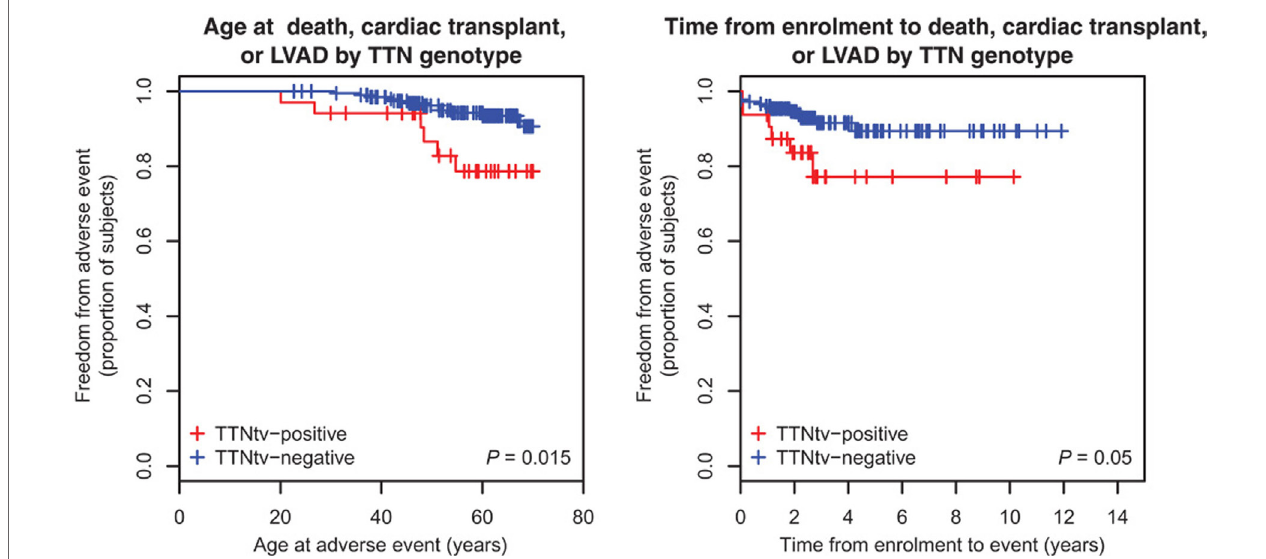
FiGURe 4 | Survival of TTN truncation carriers . Patients carriers of a TTN truncation variant (TTNtv) had a worse clinical outcome when considering the age of adverse event (death, cardiac transplant or left ventricular assisted device) ( P = 0.015). They also had a worse clinical outcome when considering the time of event from enrollment (from Roberts et al., with permission)